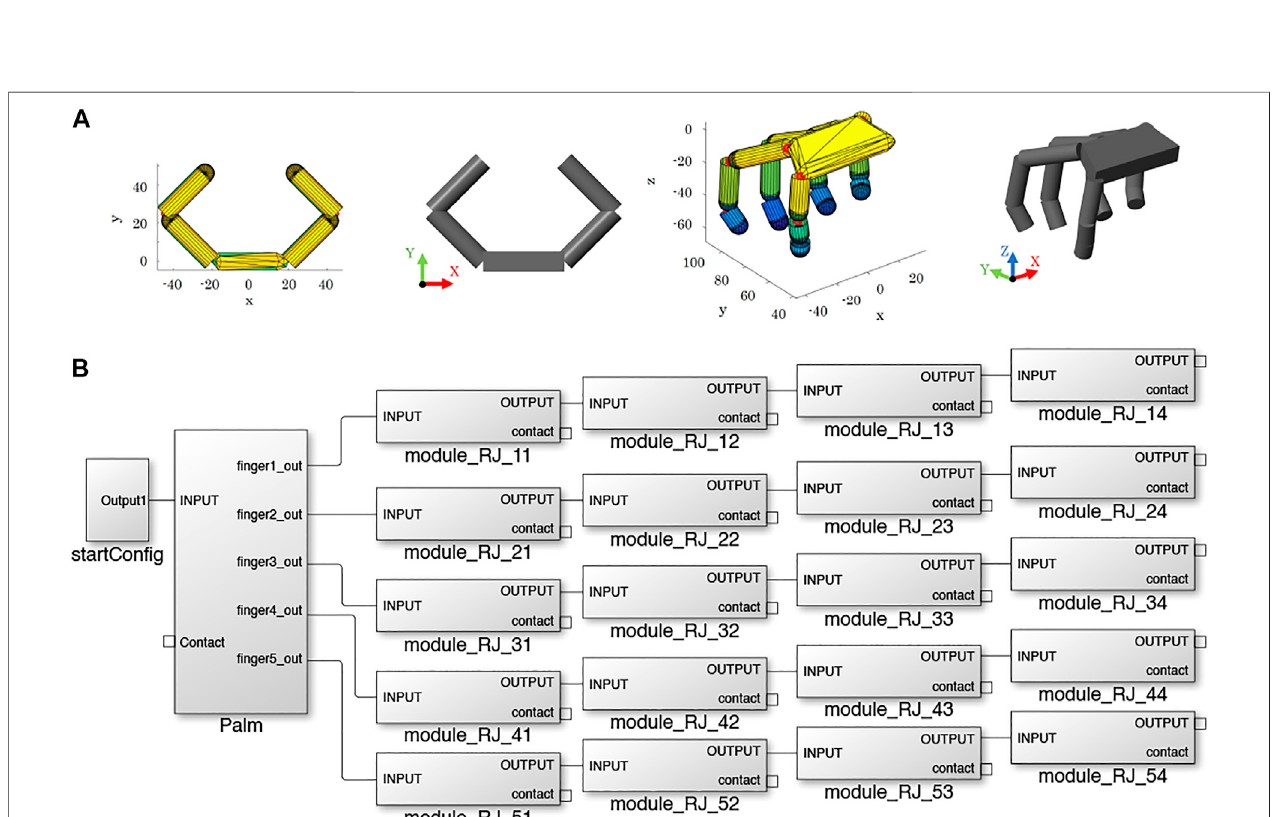
Frontiers in Robotics and AI |